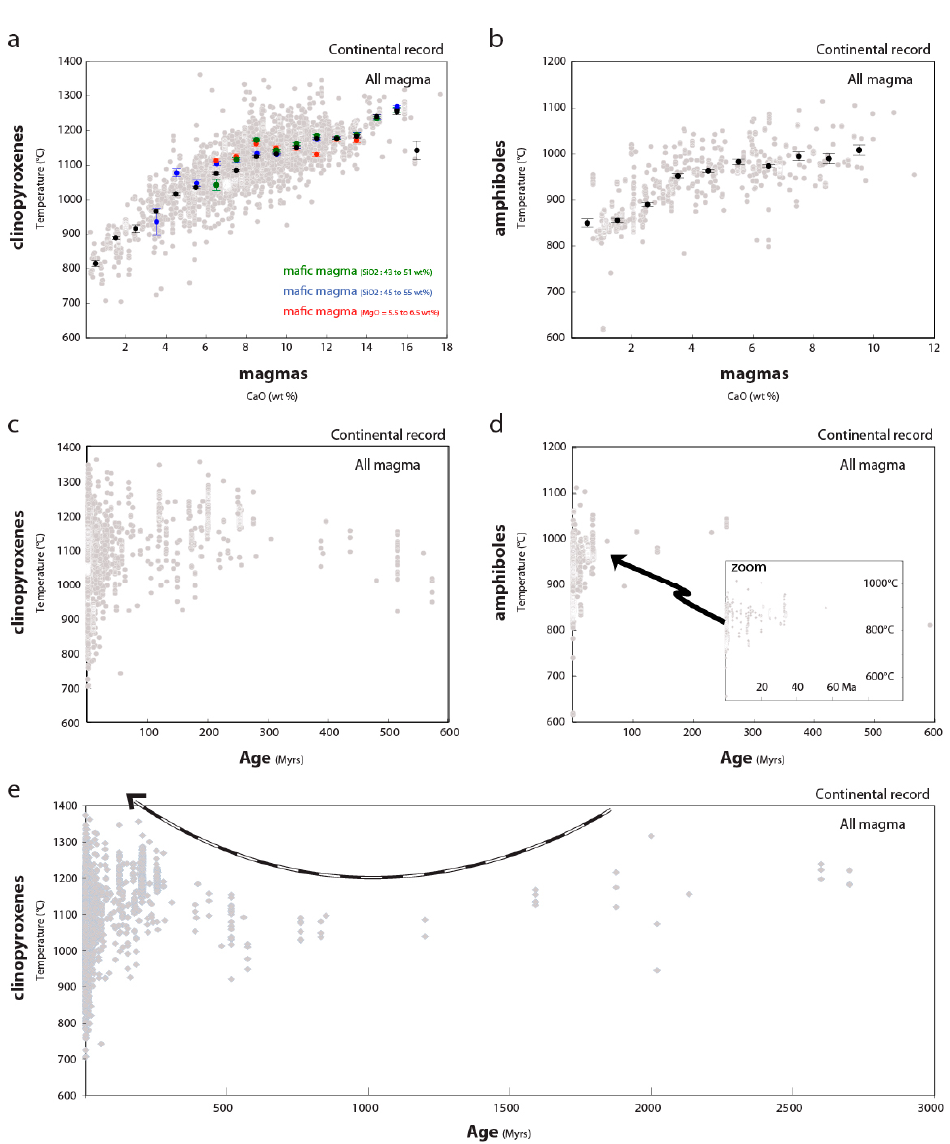
Figure 4. ( a , b ) Statistical assessment on the temperature conditions of amphibole (amph) and clinopyroxene (cpx) crystallization in magma (lava, continental s.l. record), using the min-Liq method [38], plotted against the composition of young Cenozoic magma (ca. 10–0 Myrs) hosting these minerals. Black and colored dots correspond to the bootstrapped values (1000 draws, threshold value of 3, uncertainty bars corresponding to ±1 σ standard deviation, chemical step of 1 unit). The black dots concern all magma in equilibrium with amph and cpx whereas the colored ones correspond to mafic magma, selected by ranges of composition in Si or Mg. It confirms that a positive correlation exists between Ca content of magma and temperature of crystallization for amph and cpx. Whatever the range of composition considered for mafic magma (Si 43–51 ; Si 45–55 or Mg 06 ), the slope of correlation appear broadly similar. ( c , d ) T conditions of cpx and amph crystallization using the min-Liq method [38], plotted against the age of magma. The data illustrates an increase in low-T (T < 1000 °C) cpx and amph occurrence from ca. 0.3 Gyrs to present day [31], following a ~300 Myrs period dominated by the apparent absence of high-T cpx. Though, a temporal bias could exist in the Paleozoic times. Accordingly, an intriguing lack of mineral analysis is clearly observed in the Precambrian record ( e ), hampering the use of magmatic thermometers [38] to investigate the thermal evolution of mafic to felsic